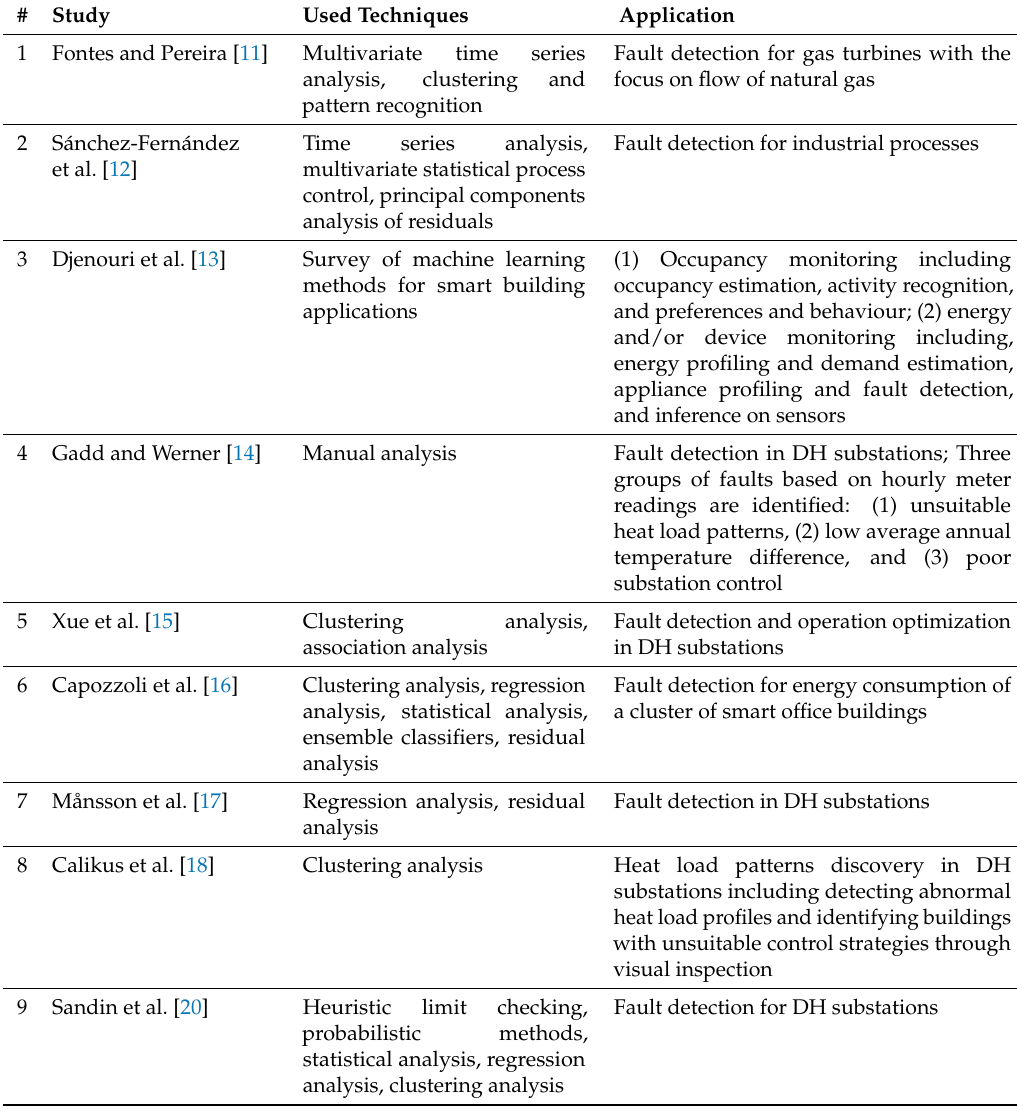
Table 1. Summary of techniques used in existing fault detection methods and their applications. DH: district